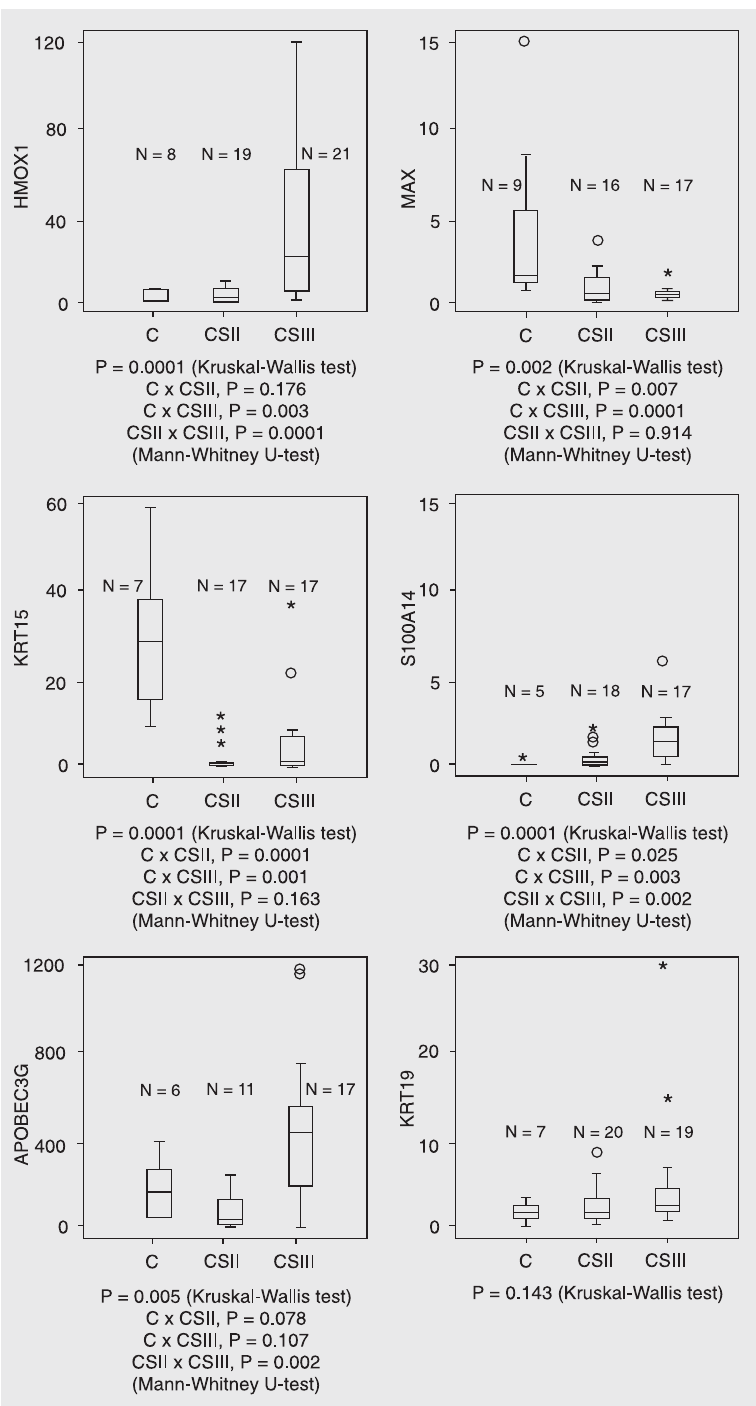
Figure 3. Gene expression in clinical stage II and III tumors and in normal breast tissue. Tumor specimens from patients with clinical stage II or III breast cancer, as well normal breast tissue from women without can- cer, were analyzed by quantitative RT-PCR. The com- parative C T method ( ∆∆ C T ) was used for quantification of gene expression and relative expression was calcu- lated as 2 - ∆∆ CT . Relative expression of genes of inter- est was normalized to that of ß-actin and gene expres- sion in each sample was then compared with expres- sion in HB4A cells. Values are shown on the y-axis. The box plot displays the distribution of all values be- tween bars (25th, 50th and 75th percentiles in the box), except outliers ( º 1.5-3.0 box lengths from the 75th per- centile) and extreme values (*values more than 3 box lengths from the 75th percentile). The Kruskal-Wallis test followed by the Mann-Whitney U-test (if a differ- ence was found) was employed and a two-tailed P ≤ 0.05 was considered to be significant. N = number of tissue specimens analyzed in each assay. C = normal breast tissue specimens; CSII = clinical stage II breast cancer samples; CSIII = clinical stage III breast cancer